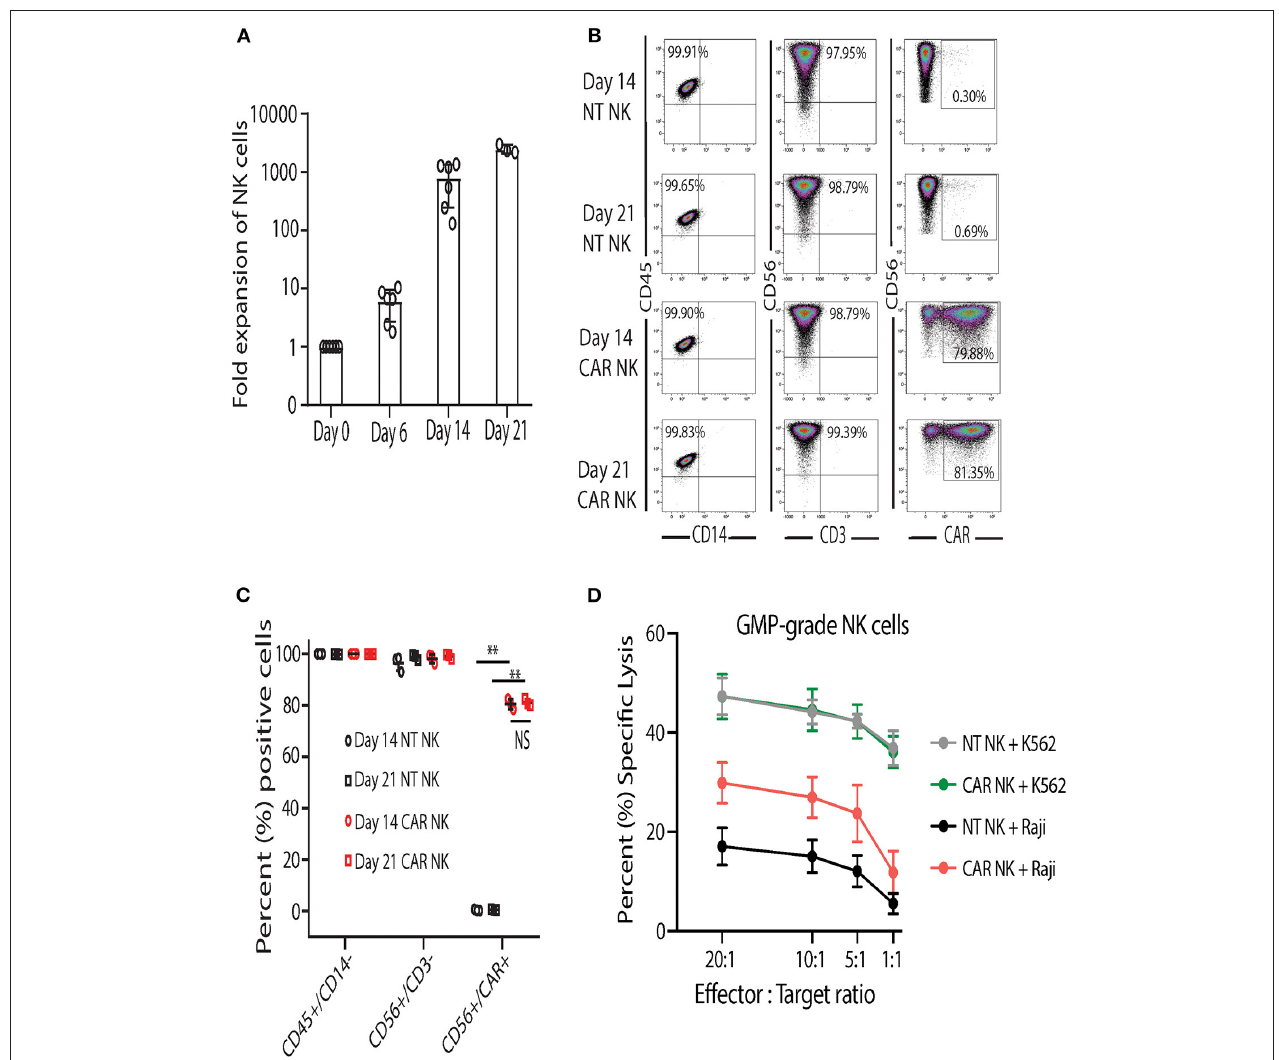
FIGURE 6 | Clinical-grade NK cells co-cultured with GMP-grade uAPC display robust expansion and antitumor activity. (A) Fold expansion of clinical-grade CB NK at day 0 (baseline) or after co-culture with GMP-grade uAPC for 6, 14, or 21 days. Bars represent standard error of the mean (SEM) ( n = 6 independent experiments). (B) Representative FACS plots showing the expression of clinical-grade NK cell lymphocytes (CD45 + CD14 − ), GMP-grade NT (CD56 + CD3 − ) and GMP-grade iC9/CAR.19/IL-15 (CAR; CD56 + CD3 − CAR + ) NK cells at days 14 and 21 after co-culture with GMP-grade uAPC. Inset numbers are the percentages (%) positive cells within the indicated regions. (C) Graph summarizing the FACS data from (B) . Each symbol (circle or square) represents an independent experiment ( n = 3). Statistical significance is determined as ** p ≤ 0.01. Bars represent standard error of the mean (SEM). NS, not significant. (D) GMP-grade NT or iC9/CAR.19/IL-15 (CAR) NK cells were expanded with GMP-grade uAPC for 14 days then co-cultured for 4h with K562 or Raji targets at different effector: target ratios and their cytotoxicity was measured by 51 Cr release assay ( n = 5 donors). Bars represent standard error of the mean